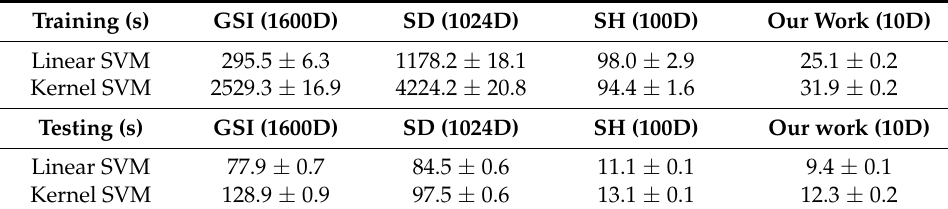
Table 5. Training and testing time